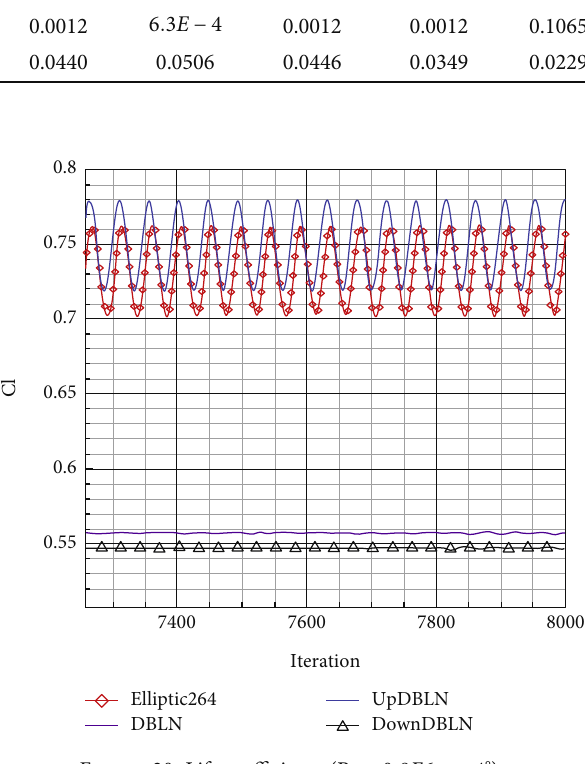
Figure 20: Lift coe ffi cients ( Re = 0 : 8 E 6 , α =4 °